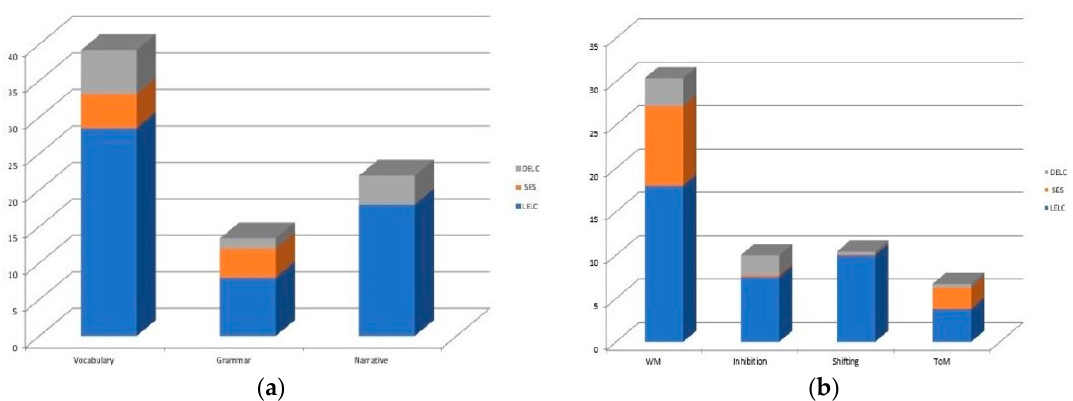
Figure 1. The percentage of unique variance explained by variation in SES (Model 1) are reported: ( a ) specific effect on linguistic skills; ( b ) specific effect on cognitive skills.